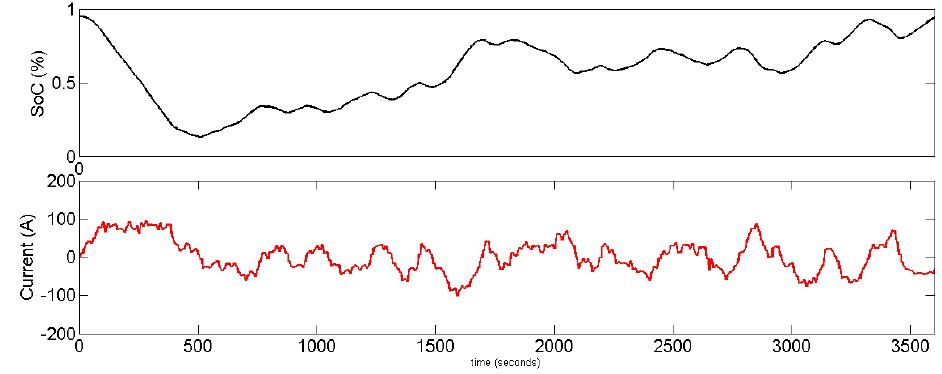
Figure 4. Battery state of charge (SoC) evolution (up) in one of the last simulated cycles following the first scenario input current (down).